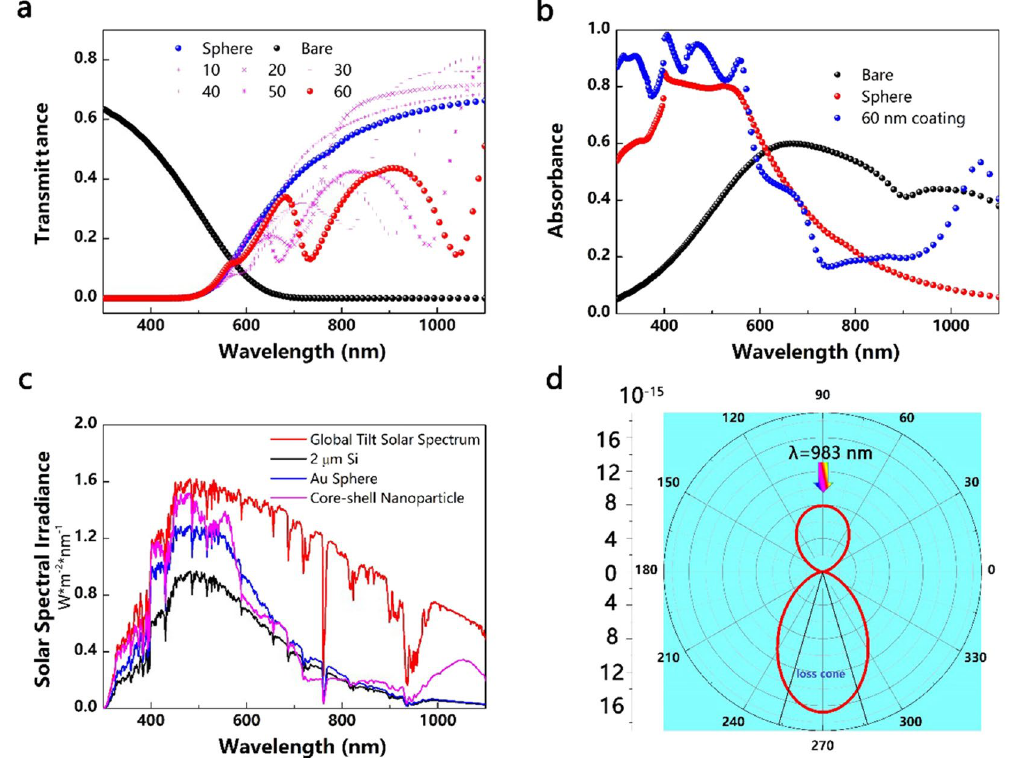
Figure 5. ( a ) Transmittance spectra of a 2 μ m thick Si, a 120 nm Au sphere and core-shell nanoparticles with different coating thickness t on the 2 μ m thick Si substrates. ( b ) Comparison of absorption spectra among a 2 μ m thick Si, a 120 nm Au sphere and core-shell nanoparticles with a 60 nm coating on the 2 μ m thick Si substrates and the P is set as 400 nm. ( c ) Global tilt solar spectrum, together with graphs that illustrate the solar energy absorbed in a 2 μ m thick Si film (assuming single-pass absorption and no reflection coating), a 2 μ m thick Si film with a 120 nm Au sphere ( P = 400 nm) and a 2 μ m thick Si film with a core-shell nanoparticle ( t = 60 nm, P = 400 nm). ( d ) Angular scattering of a core-shell nanoparticle on a 2 μ m thick Si film under 983 nm illumination ( t = 40 nm, P = 400 nm), indicating the suppressed backward scattering and the favoured forward